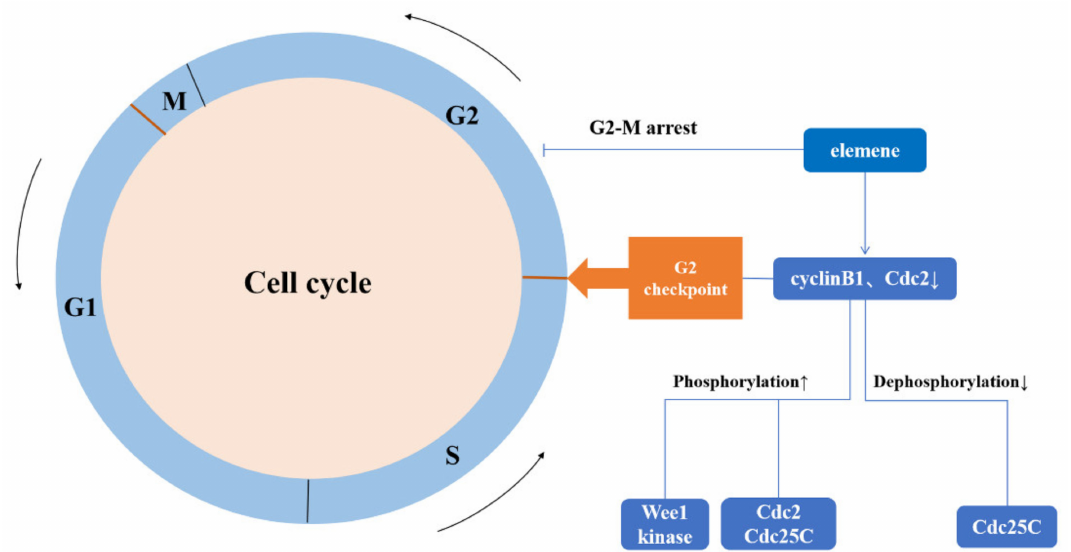
Figure 7. Pathways of elemene reversing drug resistance through regulation of the cell cycle pathway. β -Elemene blocks the G2–M cell cycle by regulating the cell cycle G2 checkpoint. Cyclin B1 and Cdc2, the cell cycle G2 checkpoints, are inactivated by an increase in Wee1 kinase phosphorylation, decreased Cdc25C dephosphorylation, and increased Cdc2 and Cdc25C phosphorylation. The symble ↑ indicates upregulated expression. The symble ↓ indicates downregulated